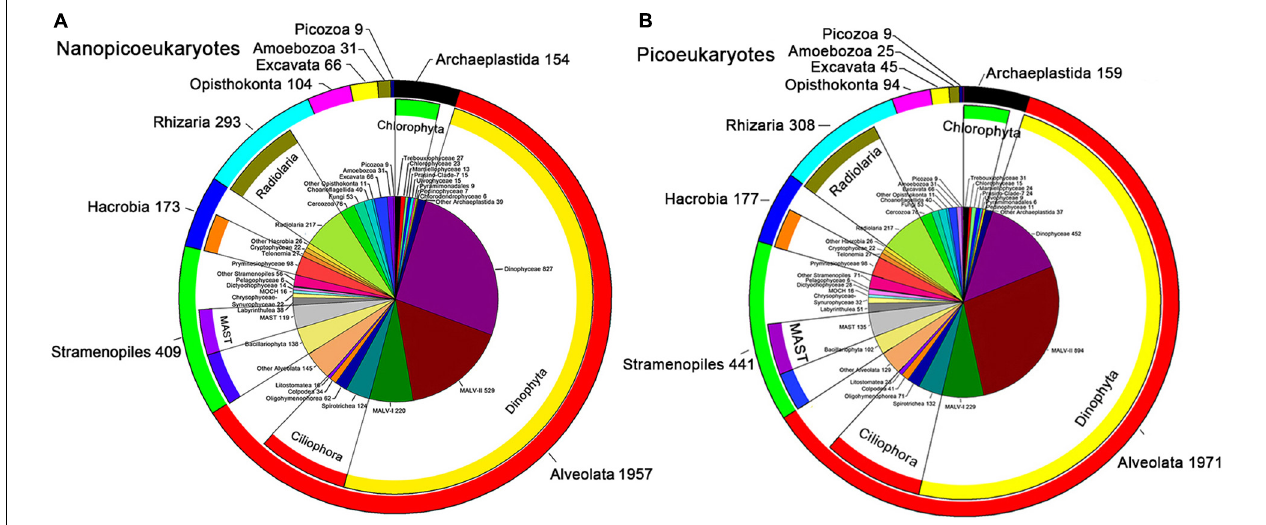
FIGURE 2 | Number of OTUs of nano- (A) and pico-eukaryotes (B) in the NSCS. The pie chart represents the numbers of OTUs mainly at class level; the inner ring indicates these classes affiliated to the phylum; the outer ring represented the OTUs numbers at super-group